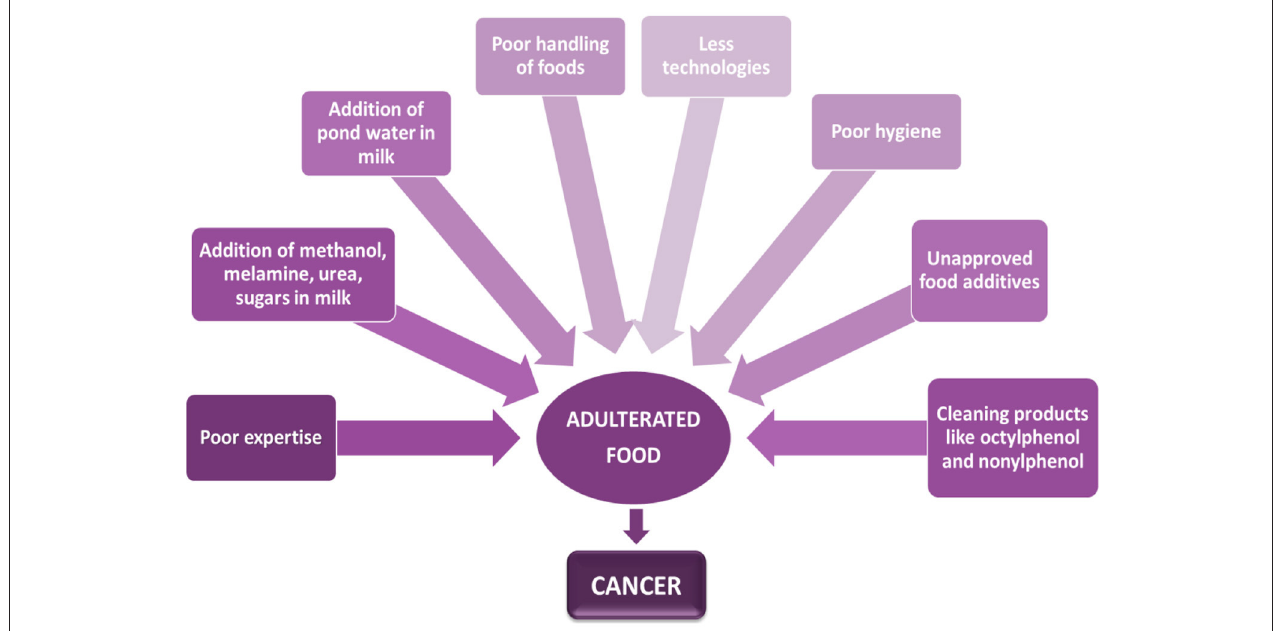
FIGURE 3 | Association between contaminated food and cancer.